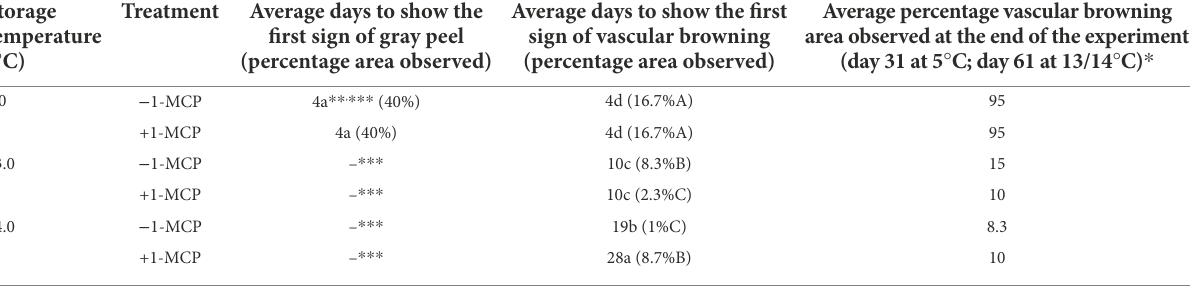
TABLE 5 Chilling injury symptom development on banana fruit that were initially treated with 0 ( − 1-MCP) or 50 μ L L − 1 (+1-MCP) aqueous 1-MCP for 60 s at 23.0 ° C and then transferred to 5.0 ° C, 13.0 ° C or 14.0 ° C storage with 95% RH ( n = 3). Storage temperature